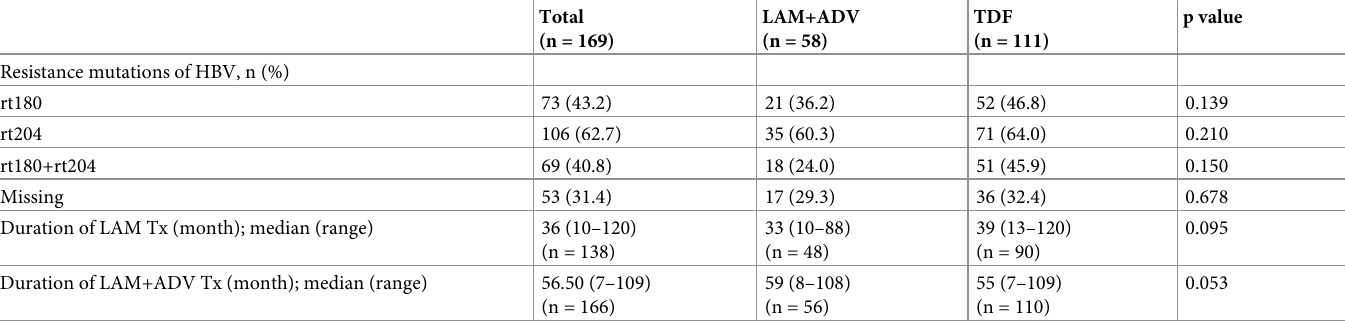
Table 2. LAM-resistance mutation profiles and previous treatment period.